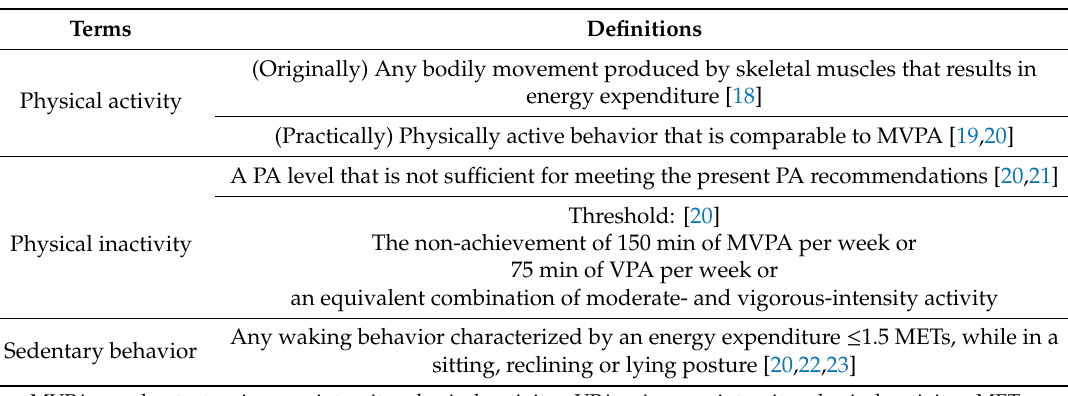
Table 1. Definitions of physical activity.